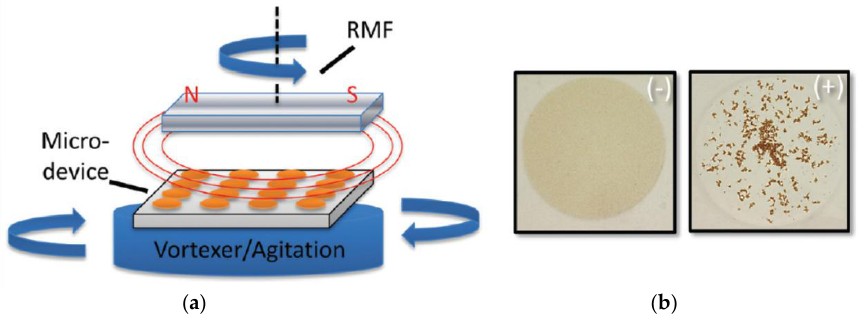
Figure 14. ( a ) Sketch of the dual-force setup combining a rotating magnetic field (RMF) and a vortexer to induce aggregation of magnetic particle clusters in the presence of analyte molecules. ( b ) The digital images show the distribution of magnetic particles within a microdevice well (well diameter 5 mm) following the agitated incubation period for a control without analyte DNA (−) and a sample with analyte DNA (+), the latter leading to agglomeration of particles visible to the naked eye. Adapted from [246] with permission of The Royal Society of Chemistry, Copyright 2015.